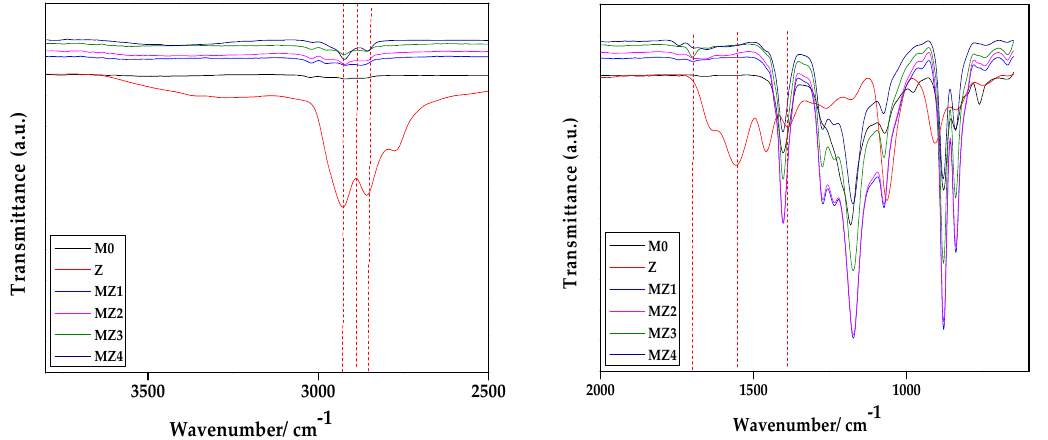
Figure 4. ATR-FTIR spectra of the PVDF and (MAO-DMPA)/PVDF composite membranes at different zwitterion contents (wt.%).